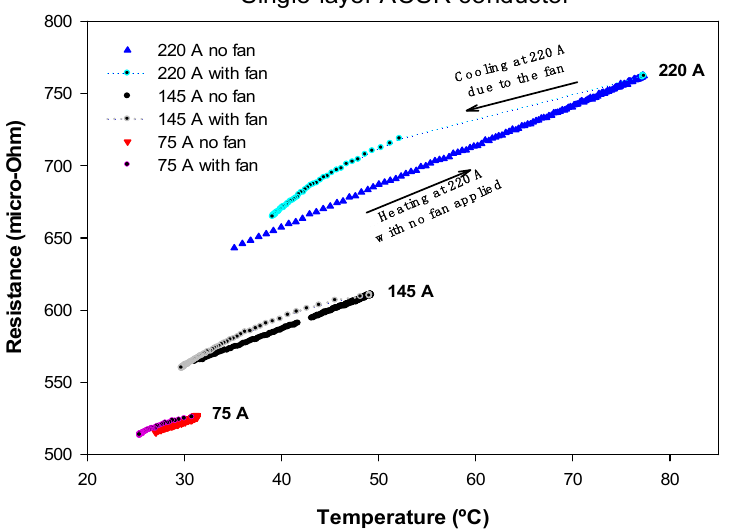
Figure 4. Single-layer ACSR conductor. R ac versus temperature measured for heating-cooling cycles at 220 A, 145 A and 75 A.